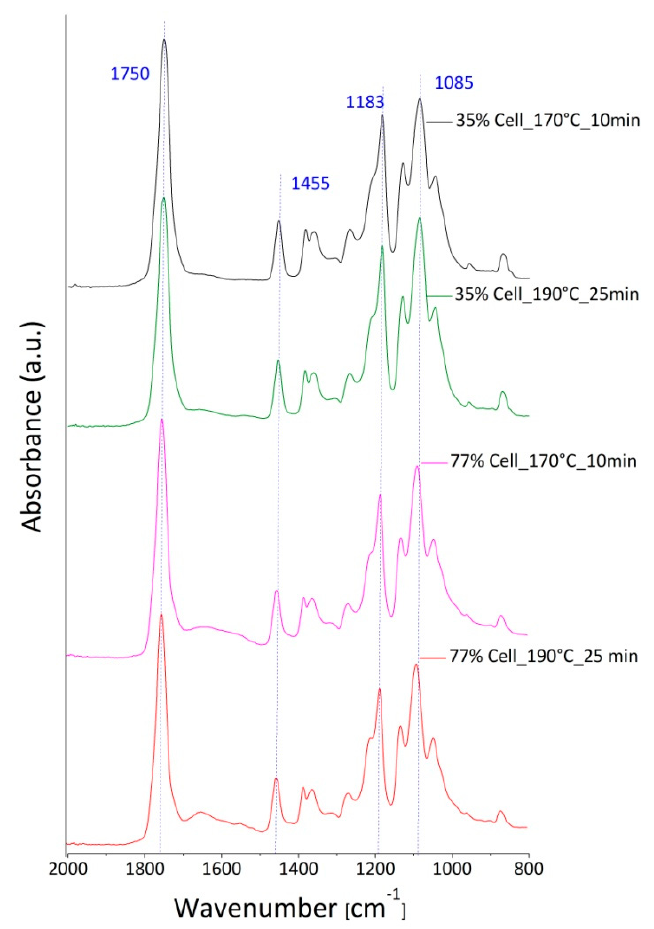
Figure 7. Comparison among the ATR spectra performed on PLA/cellulose compounds, filled with 35 vol.% of fiber content, processed at 170 °C for 10 min (black curve), and at 190 °C for 25 min (green curve), or PLA/cellulose compounds prepared with the 77 vol.% of fiber loadings at 170 °C for 10 min (pink curve) and at 190 °C for 25 min (red curve). The absorption bands considered in the analysis are highlighted by blue dotted lines. Table 3. Average normalized absorbance values, measured in correspondence to the specific wavelengths, normalized with respect to the peak at 1455 cm − 1 for the tested